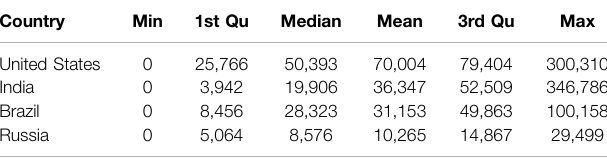
TABLE 5 | Descriptive Statistics of the United States, India, Brazil, and Russia for daily con fi rmed cases.